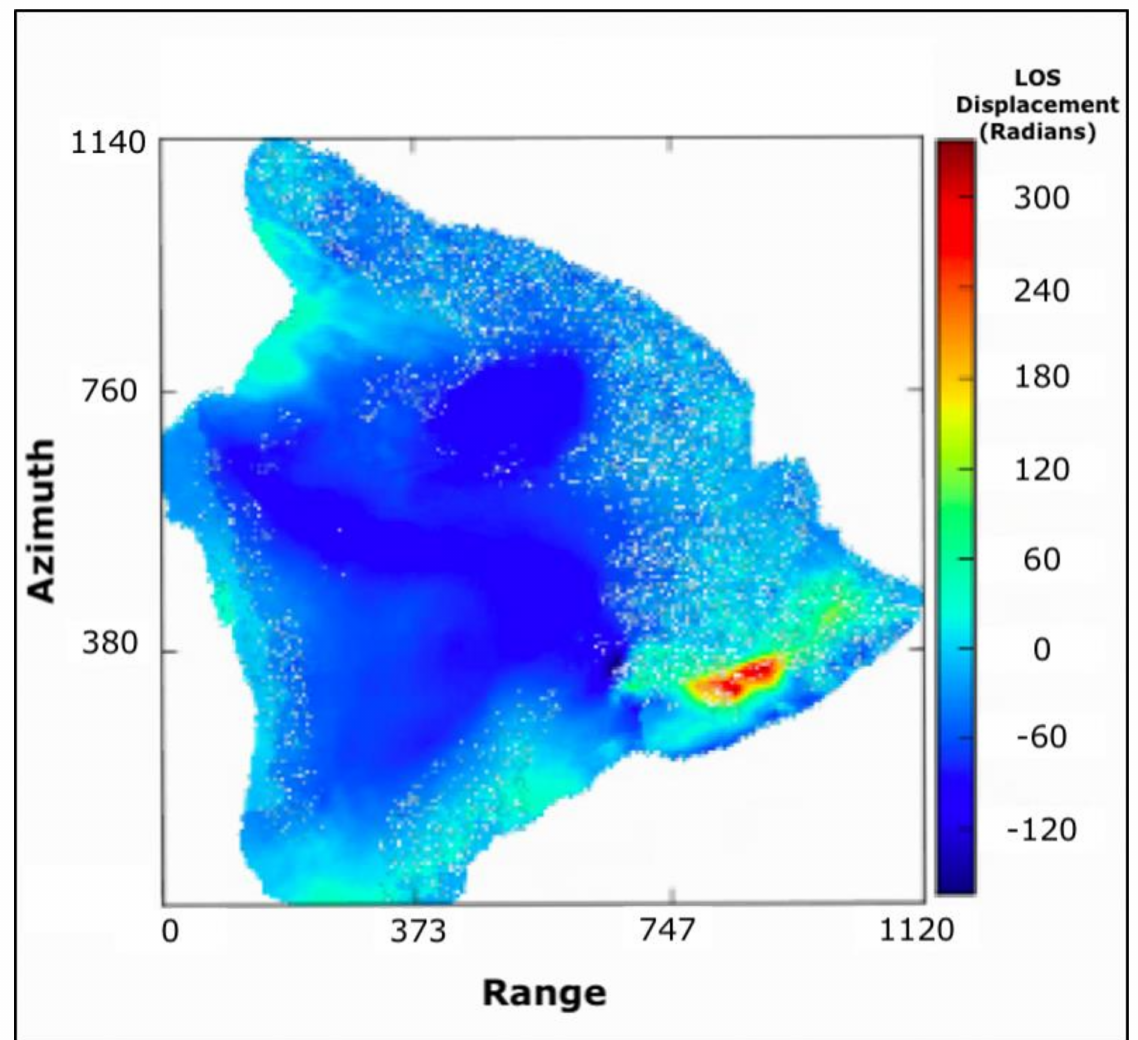
Figure 2. Example of an unwrapped LOS phase interferogram between 23 April 2018 and 4 June 2018, over the Big Island of Hawaii (Path 87 Frame 526) in units of radians from Stage 1 of the automated processing routine, based on GMTSAR. Here, warm colors and positive values are concentrated along the ERZ and represent an increase in slant range, corresponding to ground motion away from the satellite over this time. Cool colors and negative values represent a decrease in slant range, which means the ground moved towards the satellite. This color convention is reversed when the units of radians are converted to millimeters of